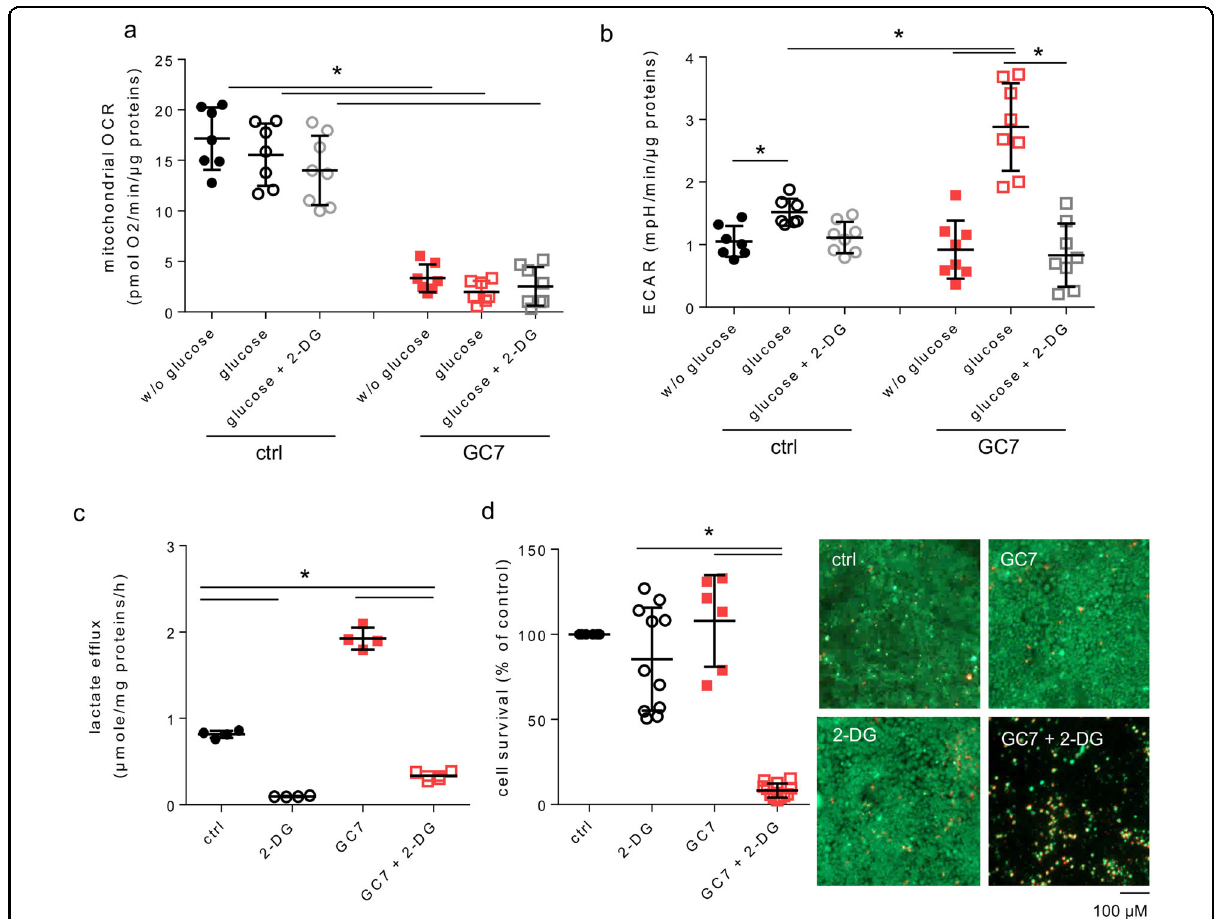
Fig. 4 Glycolysis is essential to GC7-treated cell metabolism and survival. a , b Con fl uent PCT cells were treated or not with 30 µM GC7 for 24 h and then ( a ) oxygen consumption (OCR) and ( b ) extracellular acidi fi cation (ECAR) rates were measured using Seahorse technology. Analysed was performed fi rst without glucose and then glucose (10 mM) and 2-deoxy-glucose (2-DG, 25 mM) were sequentially added as indicated. c Con fl uent PCT cells were treated or not with 30 µM GC7 for 24 h and by 25 mM 2-DG the last 8 h. Graphic displayed measurement of lactate media content after 8 h related to whole-cell proteins content. d Con fl uent PCT cells were treated or not with 30 µM GC7 and 25 mM 2-DG for 24 h. Mortality was evaluated using live/dead cells fl uorescence assay. Representative pictures for each group are displayed and show live (green, calcein-FITC) and dead (red, ethidium bromide homodimer) cells. Scale bar is indicated. Graphics displayed scatter plot of 8 ( a , b ), 4 ( c ) and 11 ( d ) independent values and mean ± SD. * p < 0.05 evaluated using Kruskal –